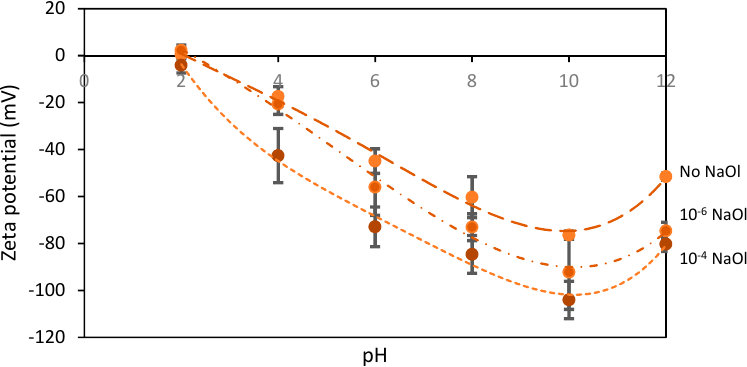
Figure 4. Effects of NaOl on the zeta potential of spodumene under different pH conditions.